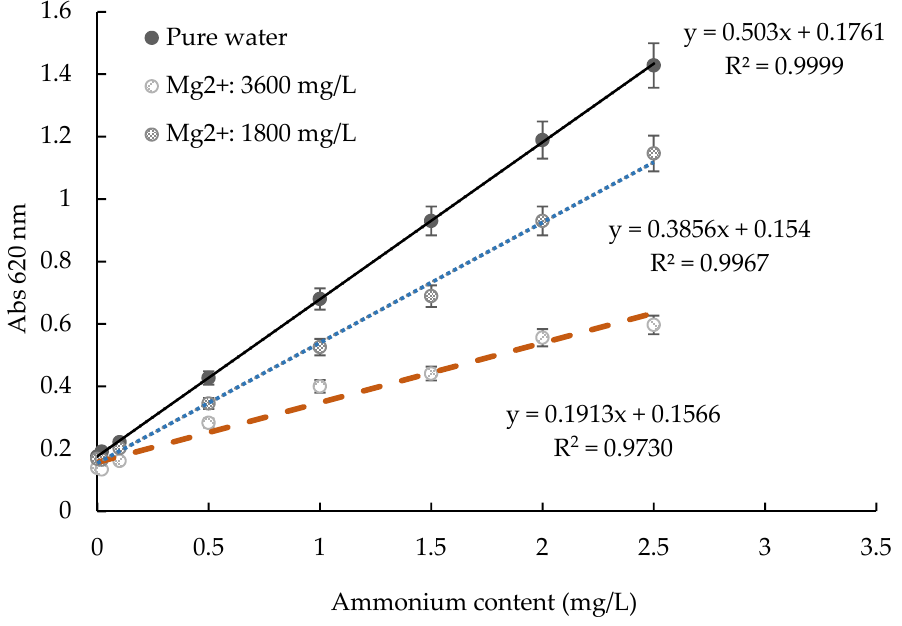
Figure 4. Comparison of the changes in the ammonium working curve with different Mg 2+ concen- trations for a test kit from HACH Company.